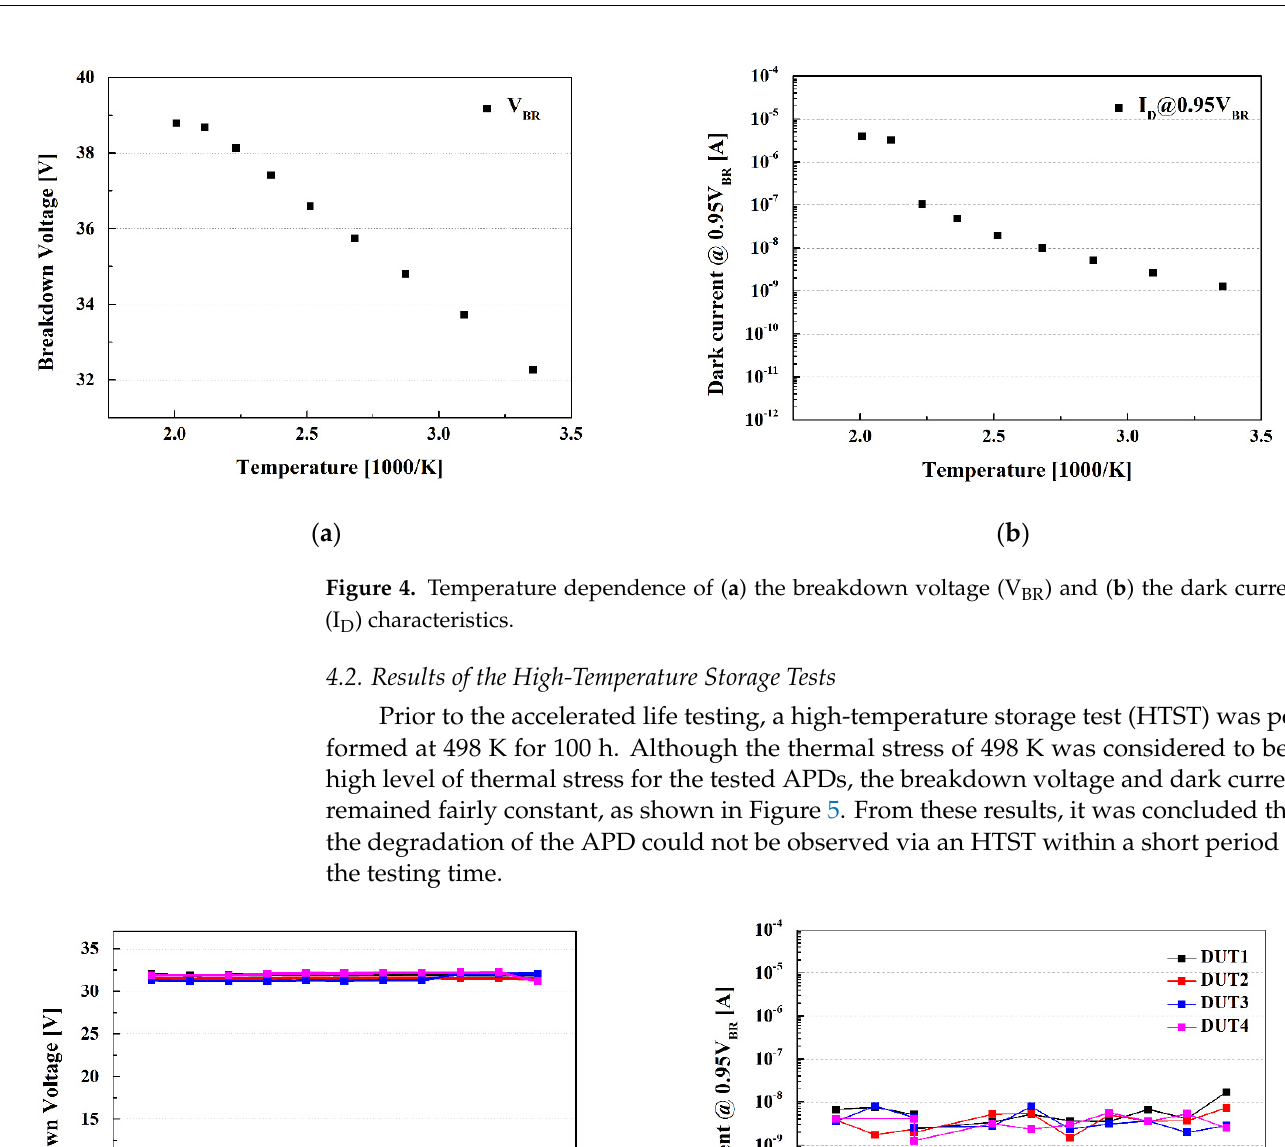
Figure 4. Temperature dependence of ( a ) the breakdown voltage (V BR ) and ( b ) the dark current (I D ) characteristics.